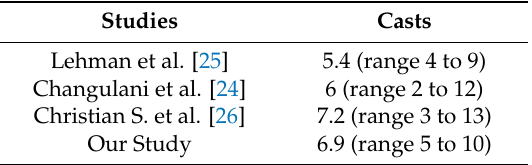
Table 8. Comparison of casts applied with other